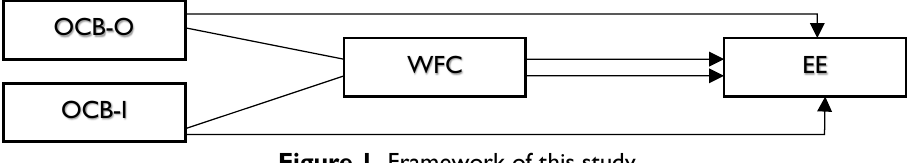
Figure 1. Framework of this study *Notes: OCB-O: Organizational citizenship behavior towards the organization, OCB-I: Organizational citizenship behavior towards individuals, WFC: Work-Family Conflict, EE: Emotional